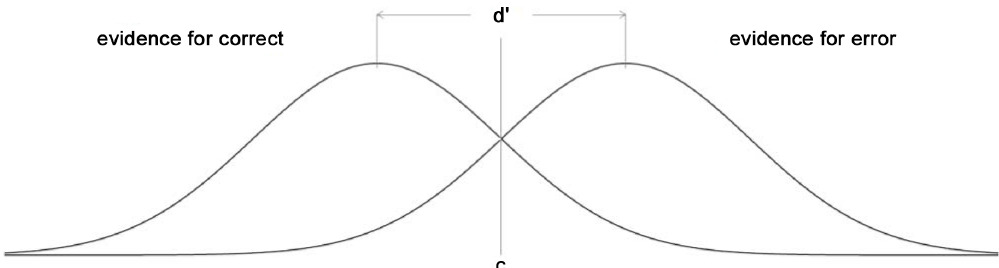
Figure 1. Logic of a signal detection analysis for spelling errors. Both correct spellings and wrong spellings induce a certain degree of evidence for a potential error. This evidence is not fixed but varies from trial to trial as a function of the noise in the system. As a result, there is a normal distribution of evidence when the spelling is correct and a normal distribution of evidence when the spelling is wrong. For someone with good spelling skills, both distributions are far apart, so that there is virtually no overlap between them. This is estimated by the distance d 9 . We can expect that d 9 will be considerably larger for controls than for dyslexics. The second variable of interest is c, the place where the decision criterion is placed. When c is at the intersection of the two distributions (as in the figure), it is positioned optimally, because then the smallest number of errors overall is made. In that case, c=0. When c is lower than 0, the participant makes too many error judgments (i.e., does so for too many words with correct spellings). Conversely, when c is higher than 0, the participant fails to see too many wrong spellings. The degree of deviation in c from 0 is therefore a good indication of the dual burden theory.